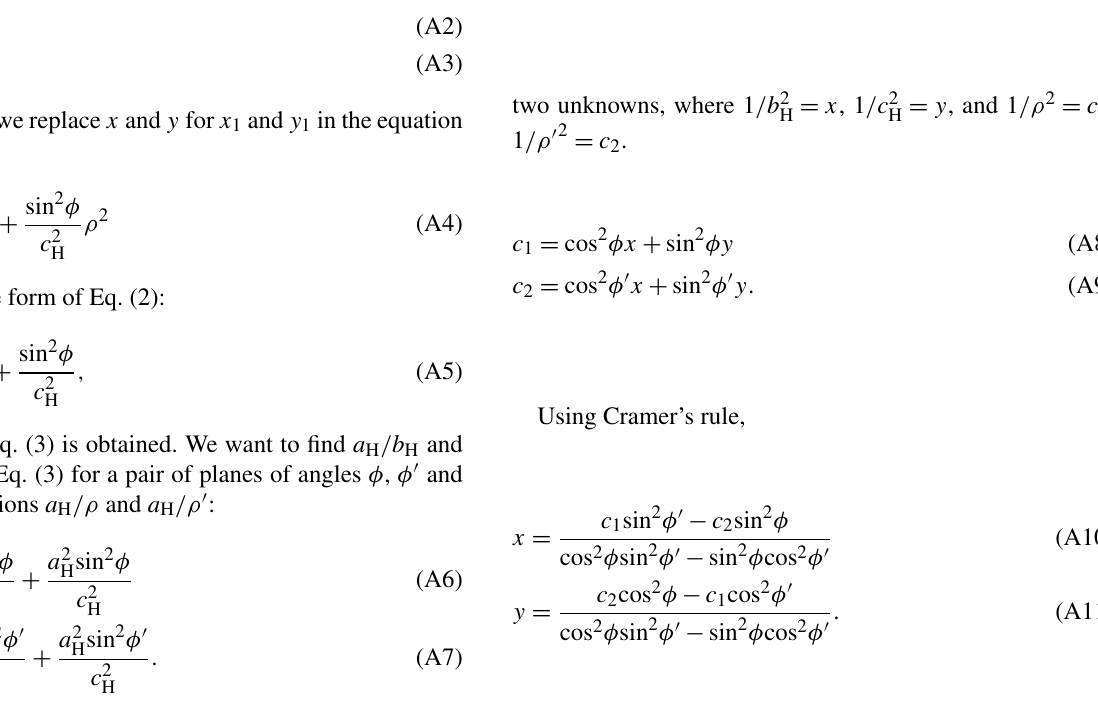
Figure A2. Geometry of an ellipse like the one in Fig. 2c, in the Cartesian coordinate